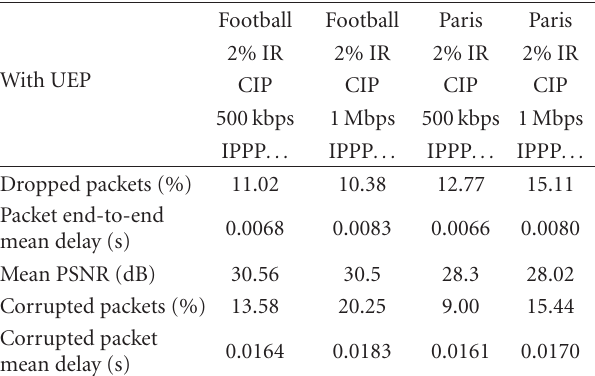
Table 3: Metrics for channel 1 with UEP.